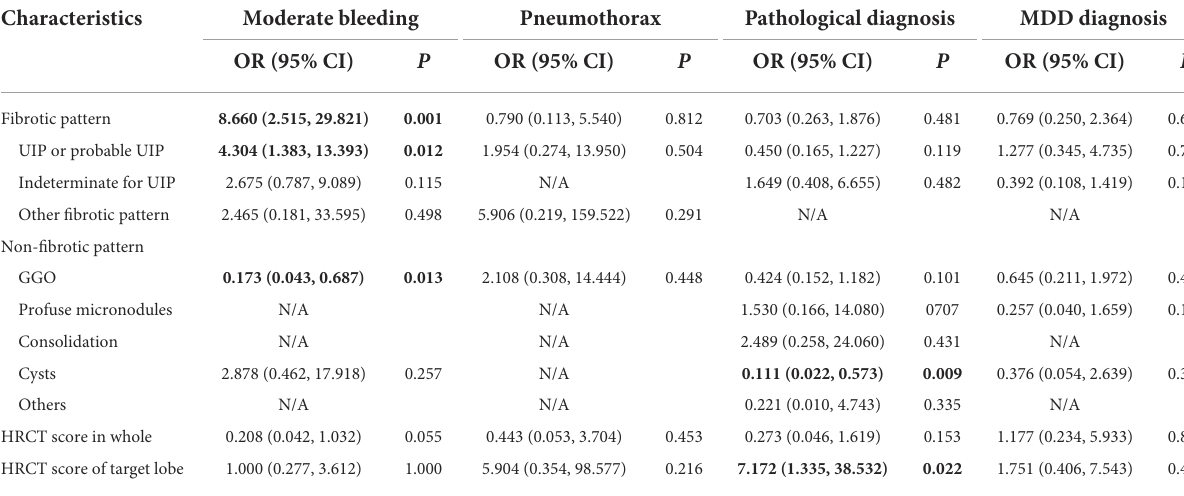
TABLE 4 Multivariate analysis for the associations between HRCT features and the outcomes of transbronchial cryobiopsy in ILD patients. Characteristics Moderate bleeding Pneumothorax Pathological